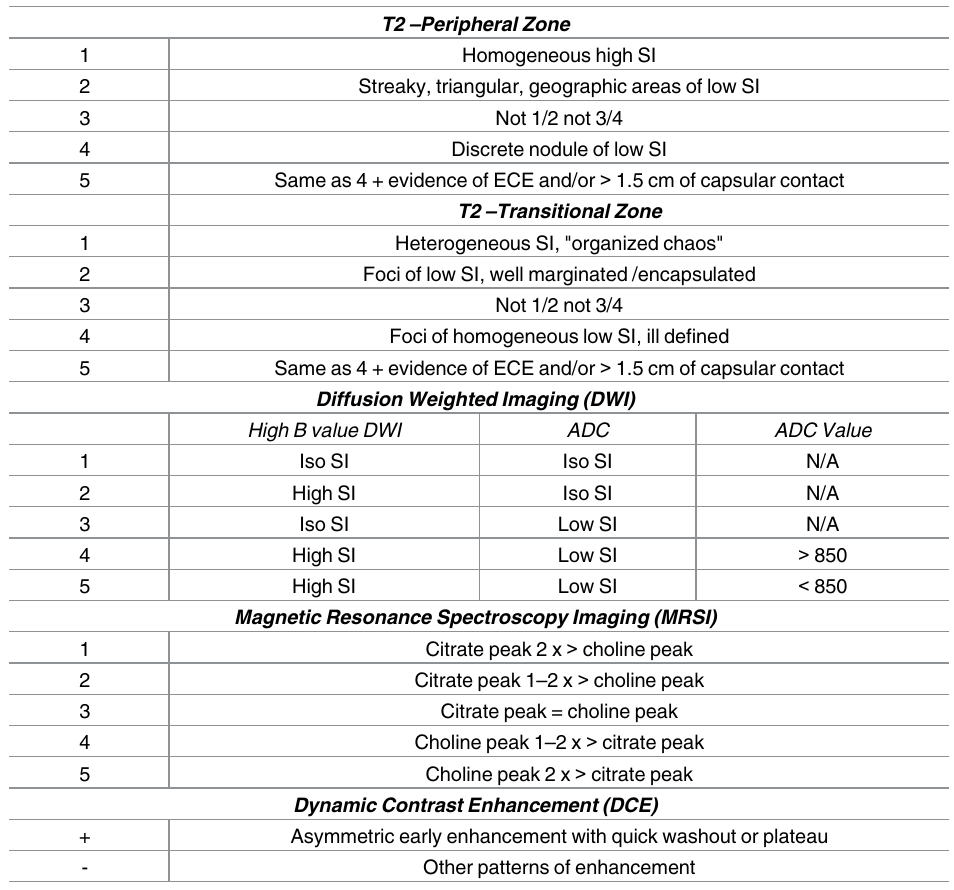
Table 1. Multi-parametric prostate MRI scoring